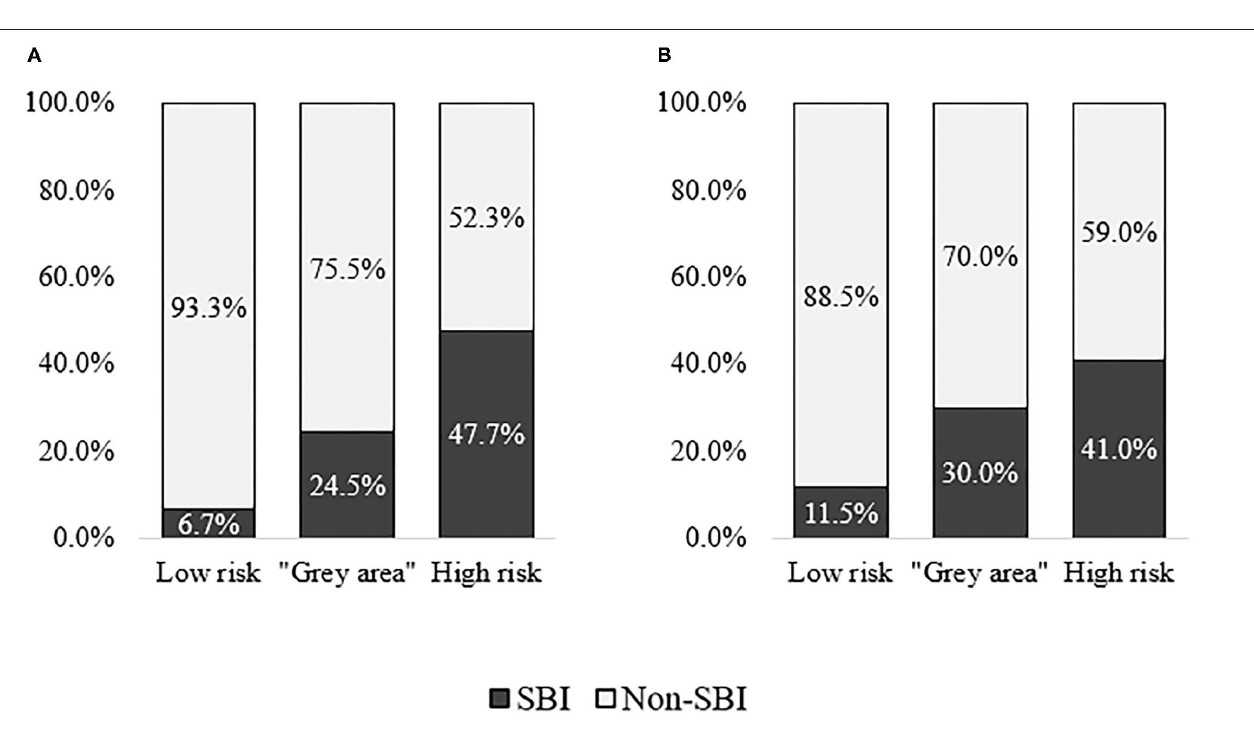
secondary). It must be noted that patients at increased risk